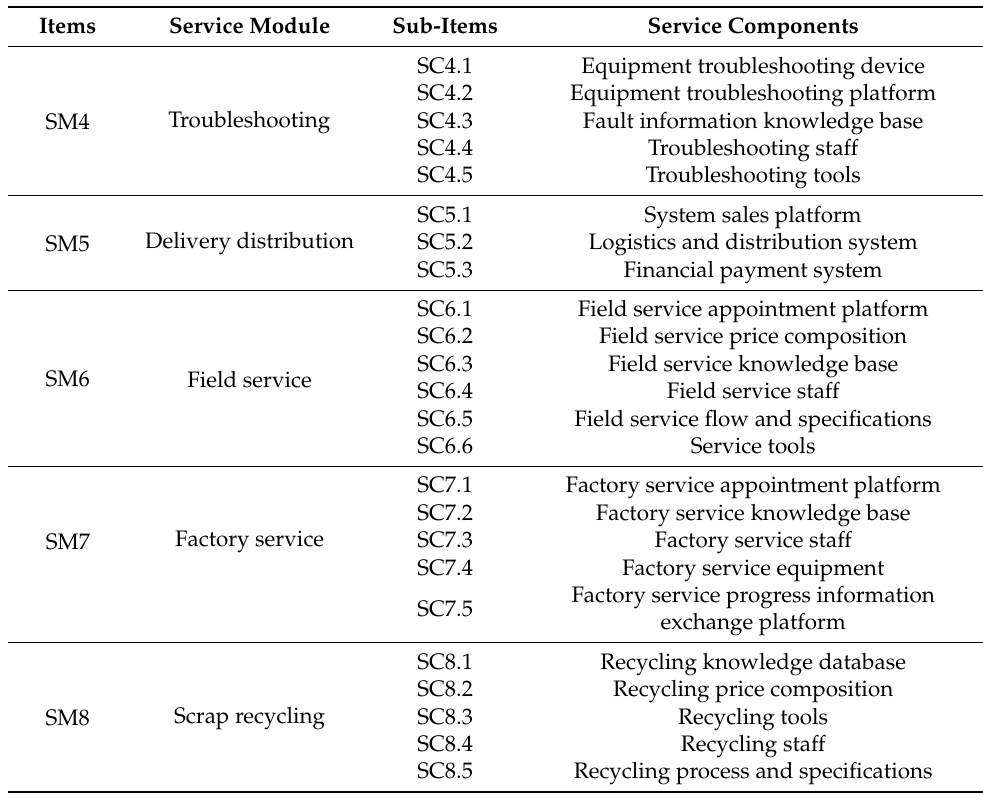
Table A2. Initial evaluation matrix of the electric forklift PSS concept (taking the CS2 as an example). (a) Scheme Value Assessment of Evaluation Criteria on the PSS Design Evaluation Criteria